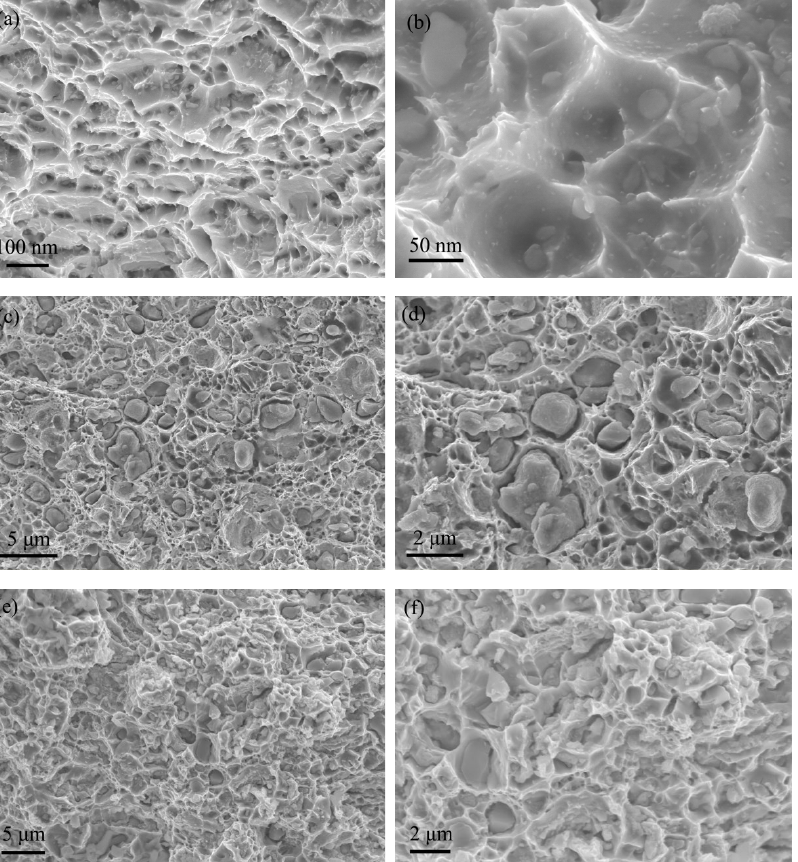
Figure 10. The fracture morphology of the composites: ( a , b ) the Gd 2 O 3 /Cu composite; ( c , d ) the Ti 3 AlC 2 -Gd 2 O 3 /Cu composite; ( e , f ) the Cu@Ti 3 AlC 2 -Gd 2 O 3 /Cu